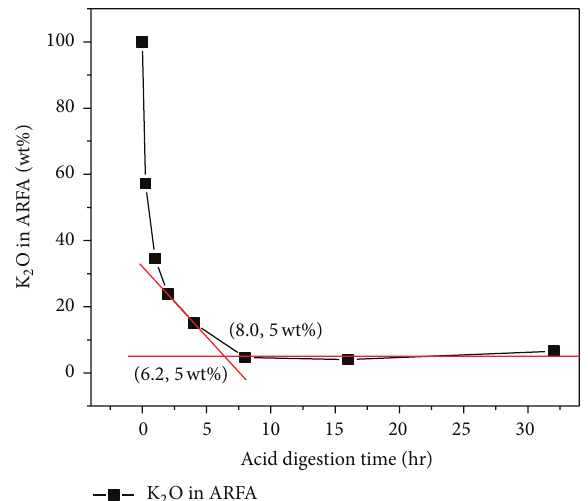
Figure 3: K 2 O in ARFA from acid digestion process.